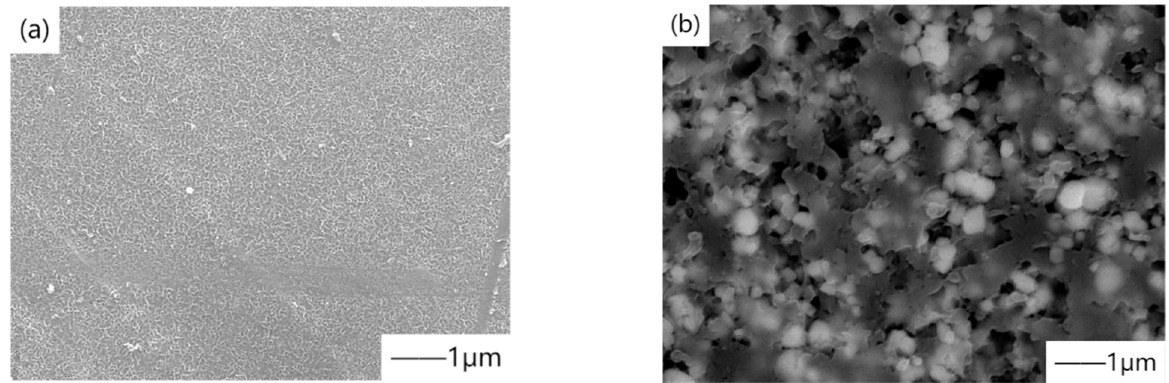
Figure 7. Comparison of SEM micrographs of Mg alloy coated with HAP and uncoated with HAP: ( a ) Mg alloy uncoated with HAP, ( b ) Mg alloy coated with HAP. Reprinted with permission from